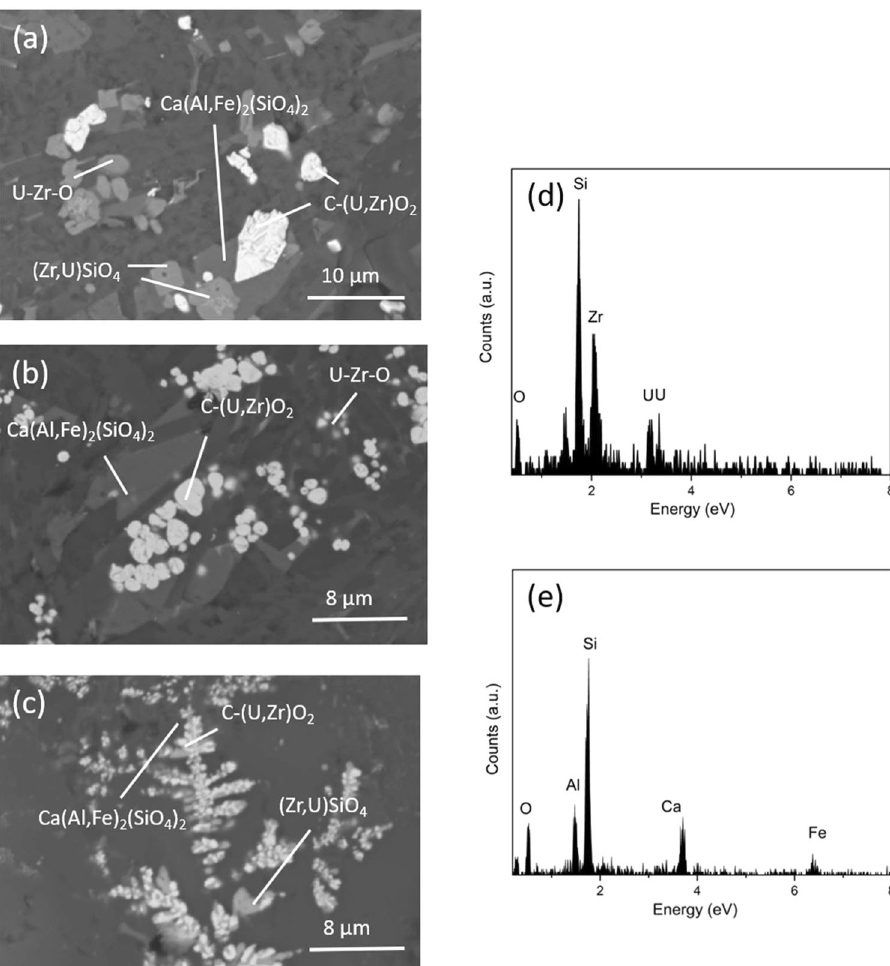
Fig. 2 SEM images and EDS spectra of simulant MCCI materials. Showing a MCCI-1, b MCCI-2 and c MCCI-3; and EDS spectra of d uranium- containing zircon and e the Al-Ca-Fe rich silicate phase, identi fi ed by XRD as anorthite. Scale bars are as follow: a 10 µm; b 8 µm; and c 8